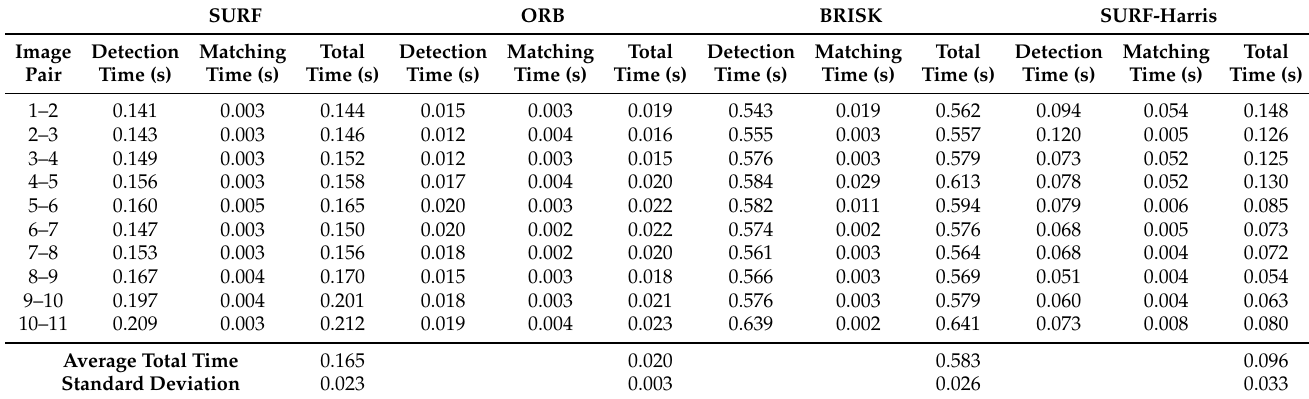
Table 10. Computation time measurements results performed for each algorithm for dataset